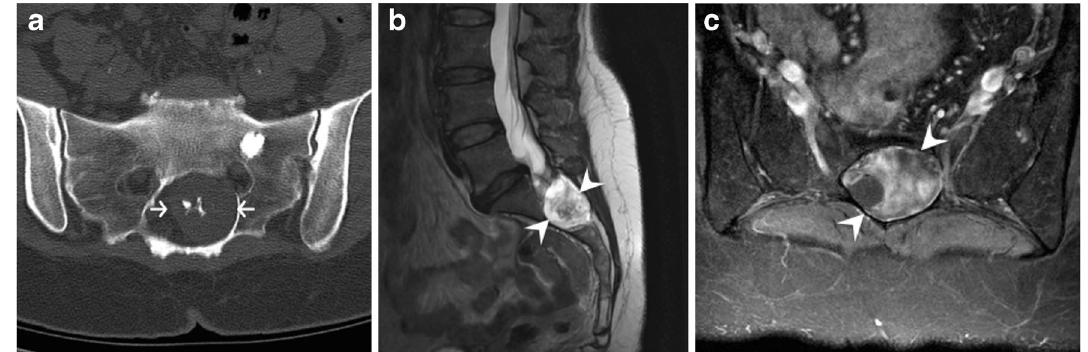
Fig. 24 Schwannoma. ( a ) axial CT image of the sacrum shows calcifications in a lesion and ( b ) sagittal T2-weighted MRI image of the sacrum (arrows) and axial fat-saturated T1-weighted MRI image of the